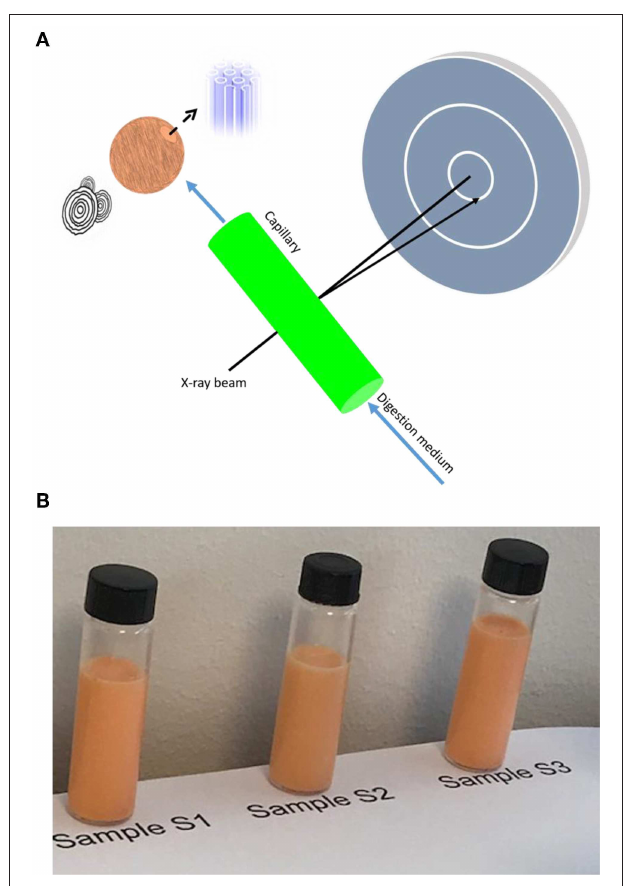
FIGURE 2 | (A) Schematic illustration of the flow-through lipolysis model combined with synchrotron SAXS for investigating the colloidal behavior of krill oil (KO) and astaxanthin oil (AO) emulsions during in vitro digestion. In this set-up, the lipolysis vessel was connected to a flow-through 1.5mm quartz capillary and pH was maintained at 6.5. SAXS findings indicated the formation of liquid crystalline nanostructures on exposure of these ω -3 PUFA-containing emulsions to the lipolysis medium. (B) Pictures taken for the three investigated samples (S1–S3) after 3 months of preparation and storage at room temperature.